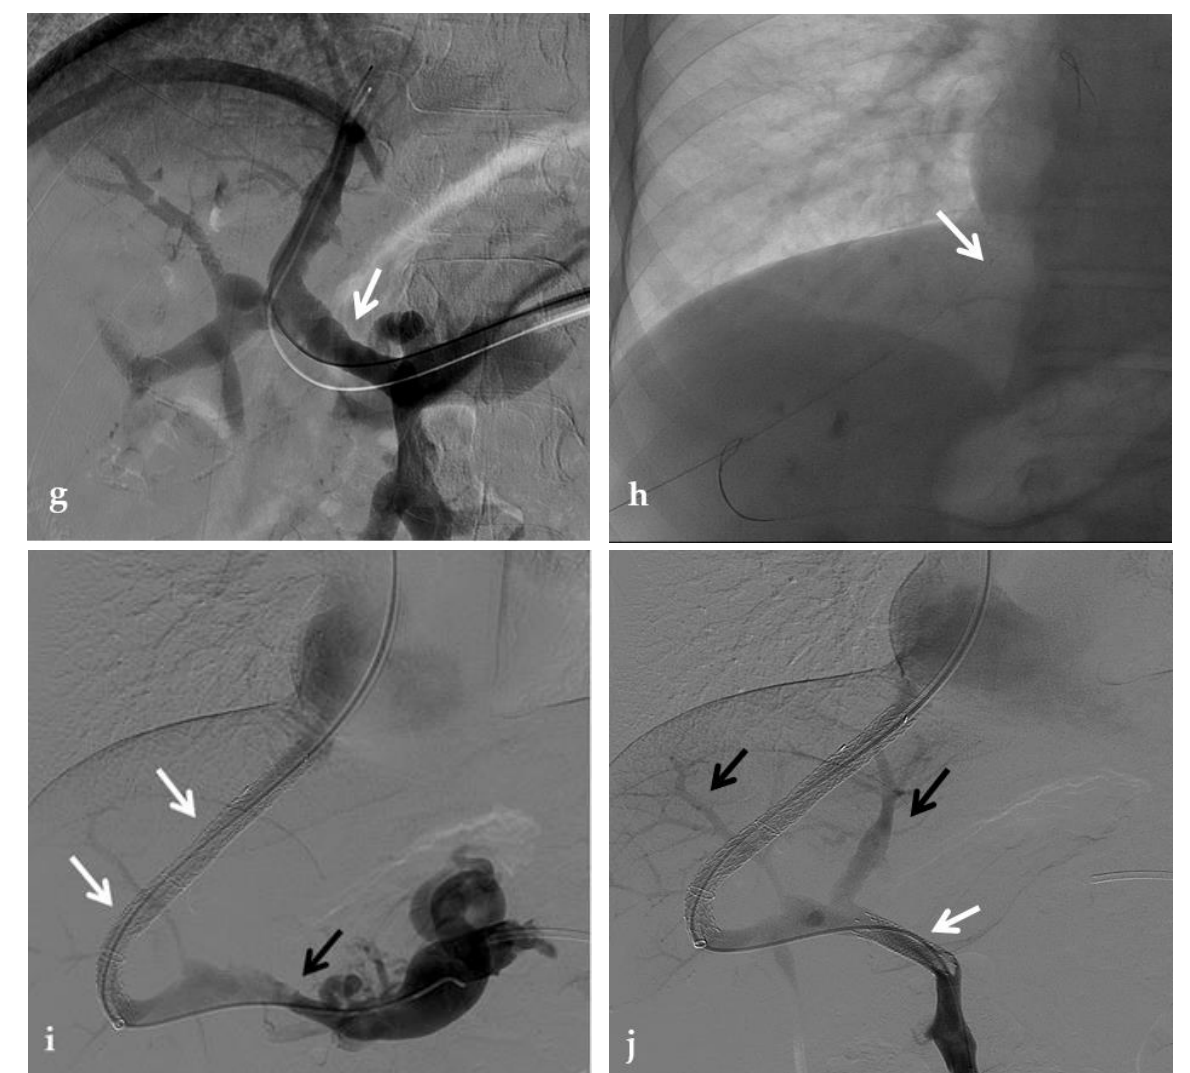
Figure 12. Anteroposterior view of a percutaneous transhepatic and transsplenic portography imaging series of a chronic complete extrahepatic portal vein thrombosis with portal cavernous trans- formation in a 17-year-old boy with a history of gastrointestinal bleeding and portal hypertension after liver transplant for biliary atresia. ( a ) Percutaneous transhepatic portography shows complete extrahepatic portal vein thrombosis (white arrow), with opacification of an irregular cavernomatous network (black arrow). ( b ) Opacification of a very tiny fibrotic cord representing the thrombosed portal trunk is seen (arrow). Several attempts to cross the portal vein occlusion failed. ( c ) Percuta- neous transsplenic anterograde portography shows complete extrahepatic portal vein thrombosis and cavernous transformation (arrow) from a different perspective. ( d ) The tiny residual of the thrombosed main portal trunk (arrow) was easily recognized on the transsplenic superior mesen- teric vein portography. ( e ) Fluoroscopic image shows angioplasty of the main portal vein, per- formed through a 12-mm non-compliant balloon catheter. The focal notch (arrow) represents the tight anastomotic stenosis that probably led to secondary thrombosis. ( f ) Fluoroscopic image shows the resolution of the focal notch (arrow) after high-pressure inflation of the non-compliant 12-mm balloon catheter. ( g ) Control portography shows an expanded main portal vein with improved hepatopetal portal flow, but still with irregular profiles (arrow). ( h ) Through a hybrid transhepatic and transjugular approach under combined ultrasound and fluoroscopic guidance, the connection between the intrahepatic portal vein and the vena cava was created advancing a 0.018” micro guide- wire into the right atrium (arrow). The wire was snared through the right transjugular access